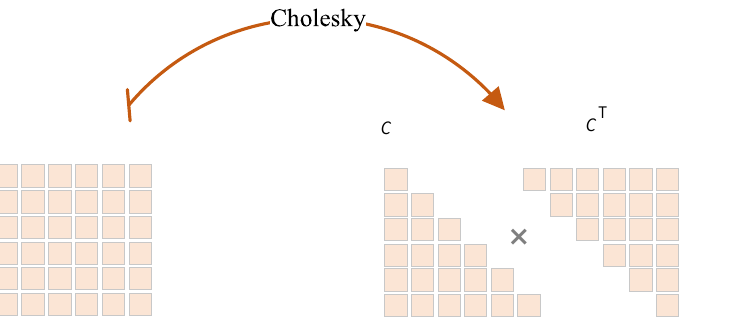
Figure 4. Cholesky decomposition. The covariance matrix is decomposed to the diagonal matrix, followed by sampling z T + 1